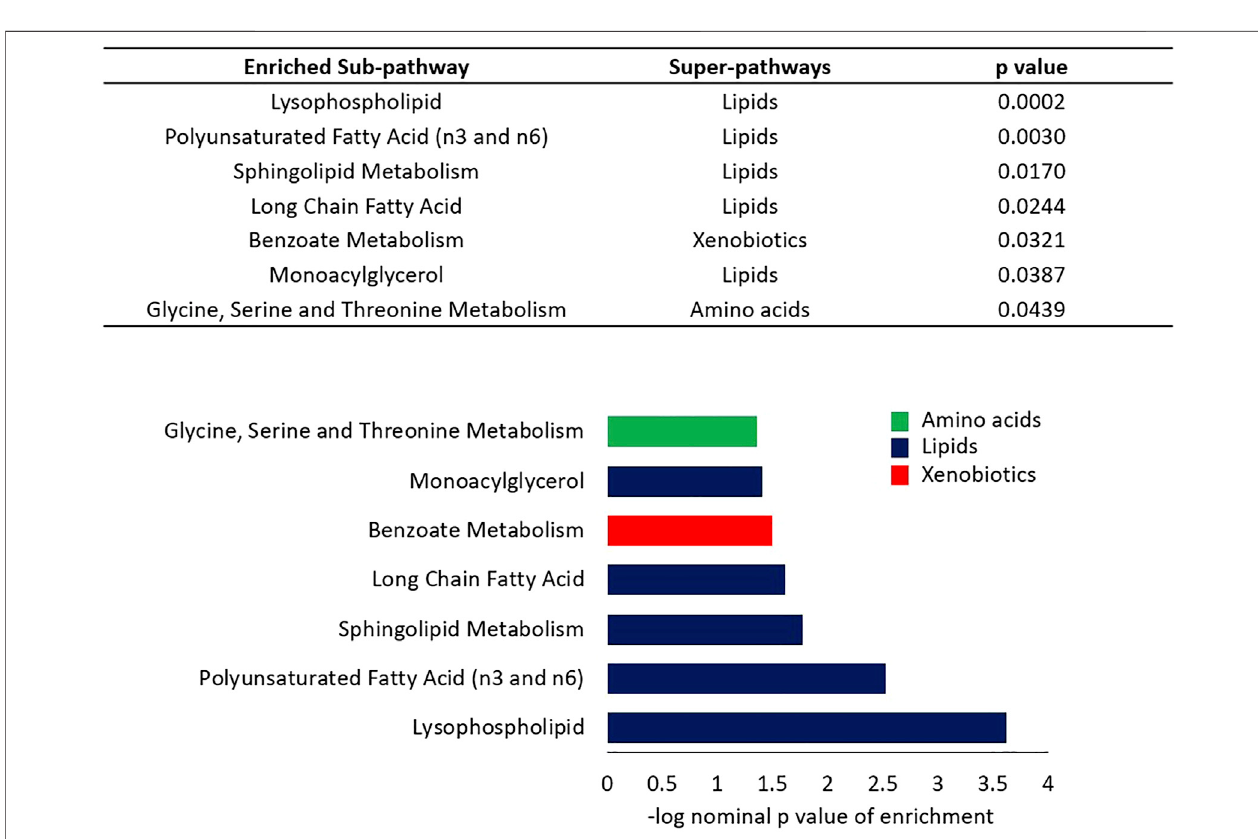
FIGURE 2 | Enrichment analysis of sub-pathways based on regression nominal p value. Wilcoxon sum of the ranks test was used to assess the probability of the observed ranks of sub-pathway metabolites when ordered by nominal p values from the linear model analysis. Colors indicate the super-pathways of enriched sub-